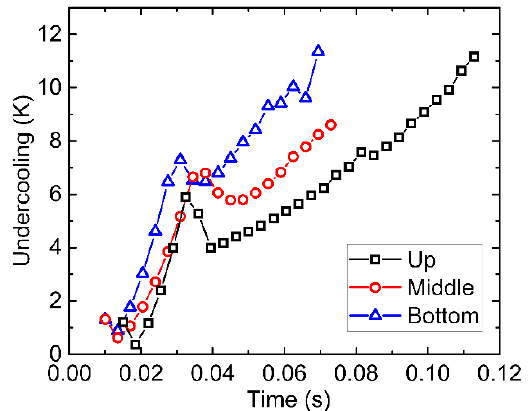
Figure 15. Time evolution of maximum undercooling in the liquid ahead of solidification front under transient conditions during laser welding.